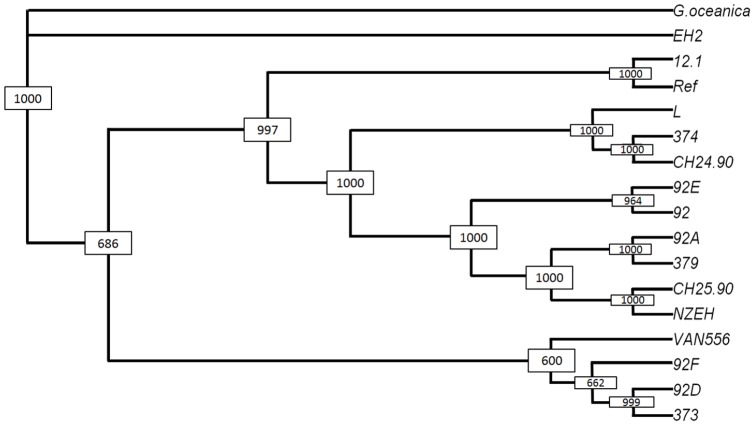
Bootstrapped neighbour-joining consensus dendogram of the 16 E. huxleyi strains and G. oceanica.Dendrogram with bootstrap values obtained from 1000 replicates of 16 E. huxleyi strains and G. oceanica as outgroup. Distances were computed from a matrix of ones (gene present with probability >95%) and zeros (rest).